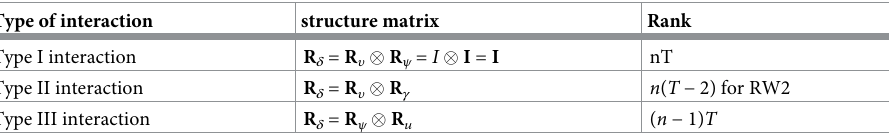
Table 1. Interaction types: Parameter interacting and rank of R δ